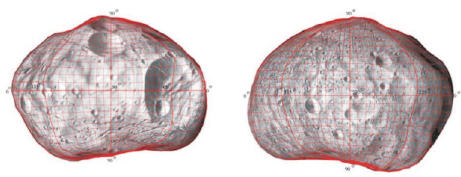
Fig. 7. The morphographic projection – Phobos (one of the moons of Mars) (M. Nyrtsov 2003)